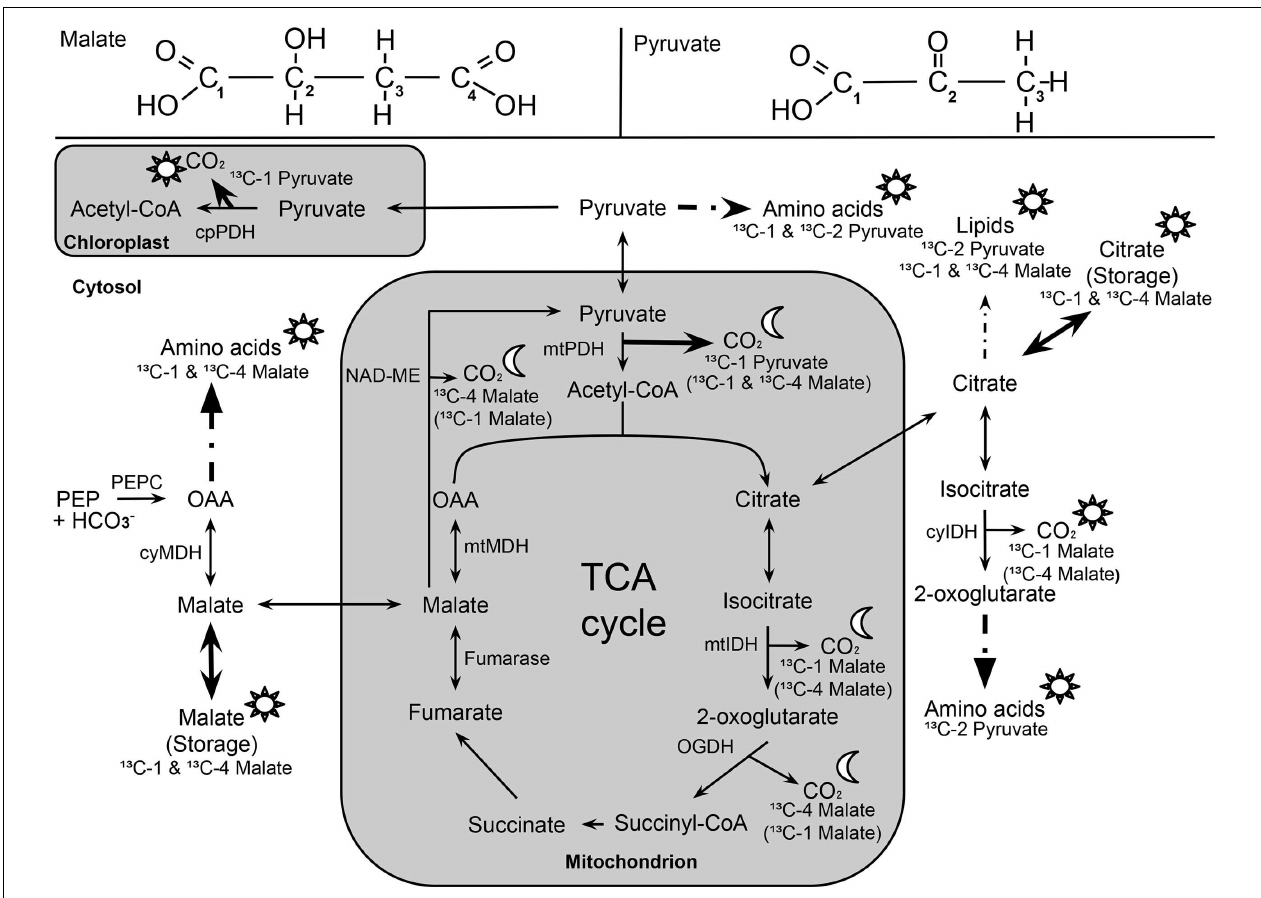
FIGURE 4 | Overview of 13 C allocation from position-specific 13 C-labeled malate ( 13 C-1, 13 C-4) and pyruvate ( 13 C-1; 13 C-2) during light–dark ) and half-moon ( ) symbols denote temporary 13 C allocation during light or dark periods (LEDR), respectively. Solid arrows indicate 13 C transitions. Sun ( allocation of highest importance, while dashed arrows indicate reactions with intermediate steps. 13 C-labeled malate substrates in brackets denote alternative (cid:36) ☼ respiratory pathways due to the influence of NAD-ME (decarboxylation of C-4 position of malate) and fumarase (randomization of C-1 and C-4 position of malate). The following abbreviations are used: cyIDH and mtIDH, NADP-cytosolic and NAD-mitochondrial isocitrate dehydrogenase; cyMDH and mtMDH, cytosolic